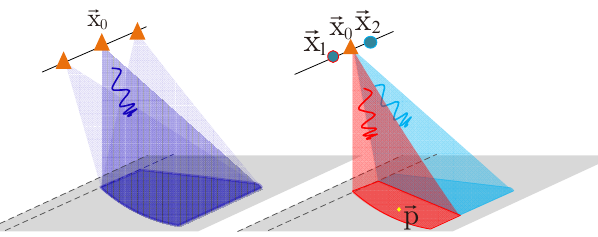
Figure 1. Subaperture summation progress. In the left panel, ‘triangle’ denotes the location where the platform transmits the signal. In the right panel, (cid:126) x 1 and (cid:126) x 2 denote two subapertures and (cid:126) x 0 denote the new synthesized